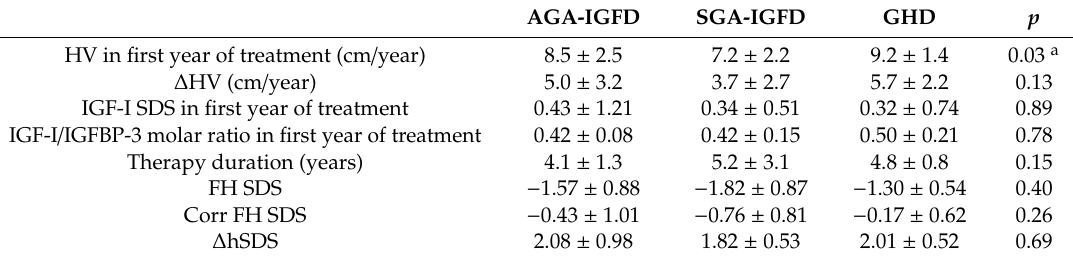
Figure 1. Patients’ height before (blue) and after (red) rhGH (recombinant human growth hormone) treatment, shown as mean with 95% confidence interval, with dots representing single patients. Triangle and square in AGA-IGFD group mark nonresponder 1 and 2, respectively (Table 3). Table 2. Data Concerning rhGH Therapy E ff ectiveness in Particular Groups of